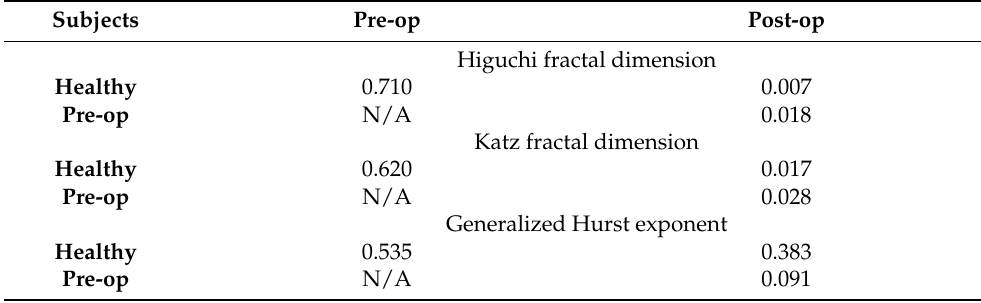
Table 4. p -values for the comparison of corneal elevation-derived FDs of the anterior surface (ELE- front) obtained from